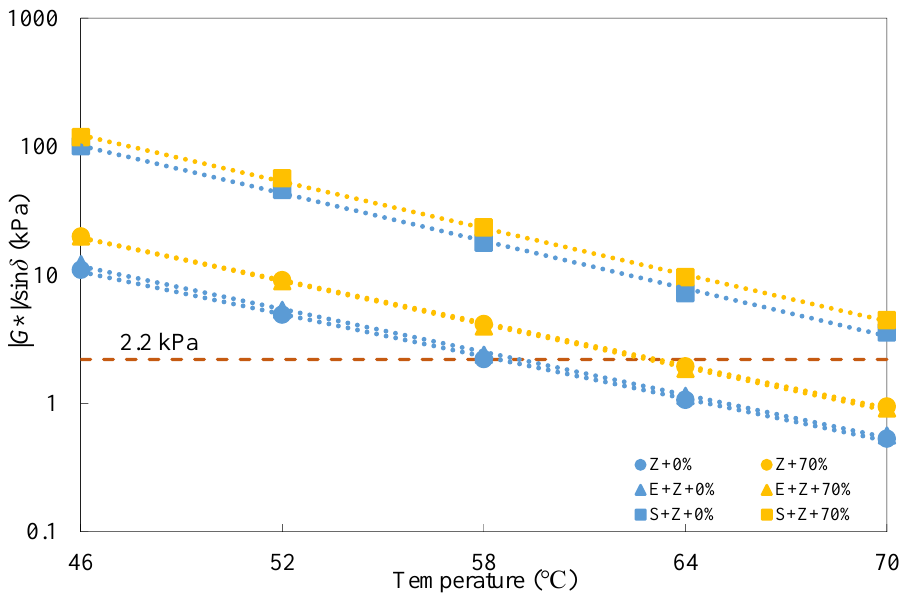
Figure 9. Rutting parameter test results of the warm-mix recycled binders at different testing temperatures under the short-term aged condition. Table 7 shows that S could alleviate the increase in | G *|/sin δ with the RAP binder content, but E intensified this percentage increase under the short-term aged condition. This observation was different from that obtained under the unaged condition. Table 7. Percentage increase in | G *|/sin δ with the RAP binder content under the short-term aged condition.